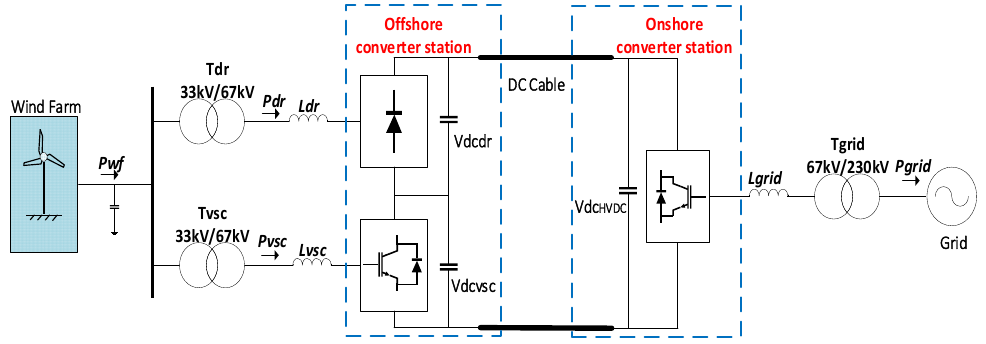
Figure 1. Proposed topology: offshore wind farm connected to a hybrid converter.